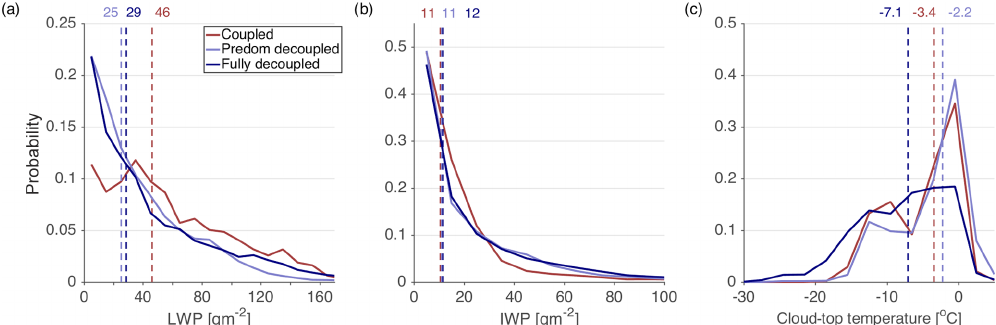
Figure 12. Comparison of LWP (a) , IWP (b) , and cloud-top temperature (c) distributions between P-MPC in weather types W and SE with different degrees of surface coupling. The dashed line and the numbers on top show the median value of each distribution. The bin size for LWP and IWP is 10gm − 2 and for cloud-top temperature 3 ◦ C. The medians were found to differ on a 95% confident level for LWP and cloud-top